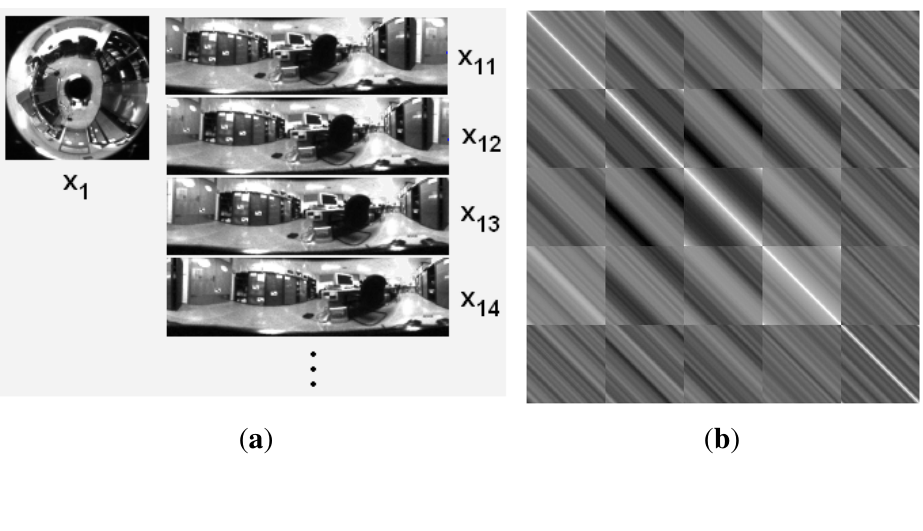
), corresponding panoramic image ( x 1 , x , x , . . . ), to carry out PCA with rotated 12 13 14